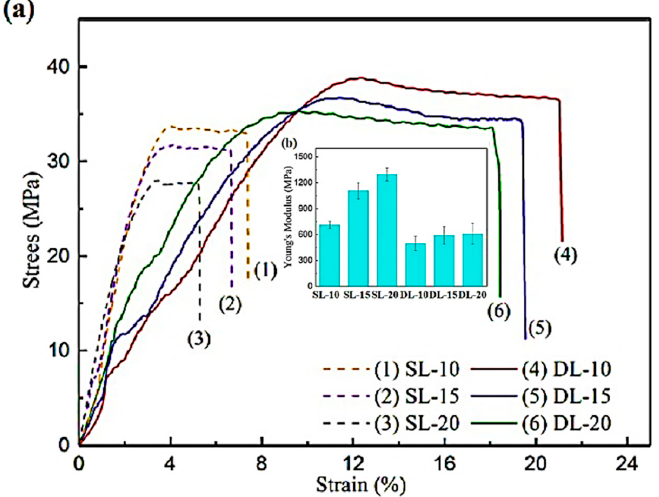
Figure 16. ( a ) Stress-strain curves, and ( b ) Young’s modulus of the PVDF/BaTiO 3 nanocomposites [46].